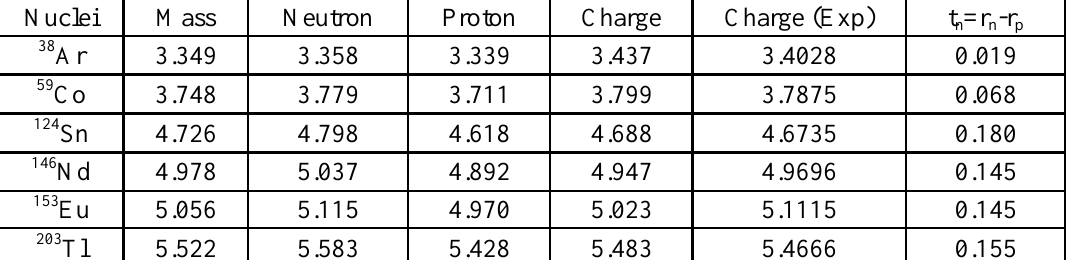
Table. 3 The calculated mass, neutron, proton and charge rms radii (in fm) using SkM* Skyrme parameterization and compared with experimental data results taken from Ref. [23] Nuclei